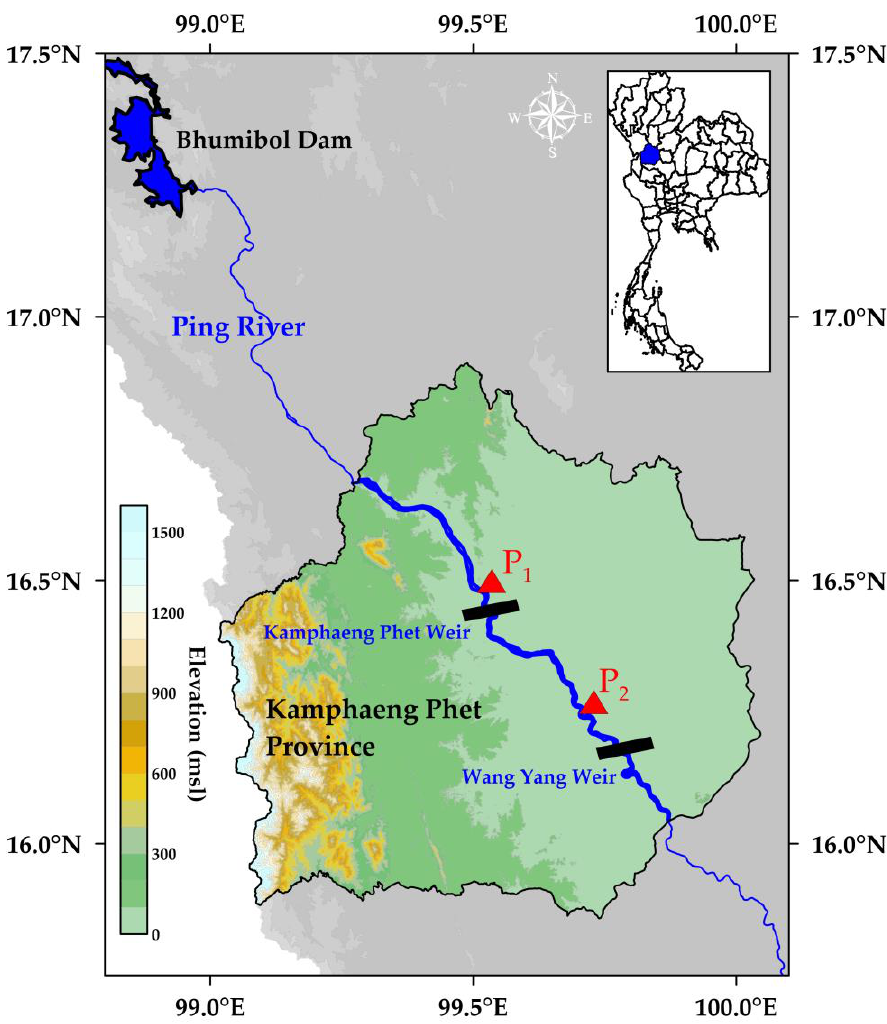
Figure 1. The study area in the Ping River basin in Kamphaeng Phet Province, including Kamphaeng Phet and Wang Yang weirs (black rectangles) and water gauge stations P 1 and P 2 (red triangles).